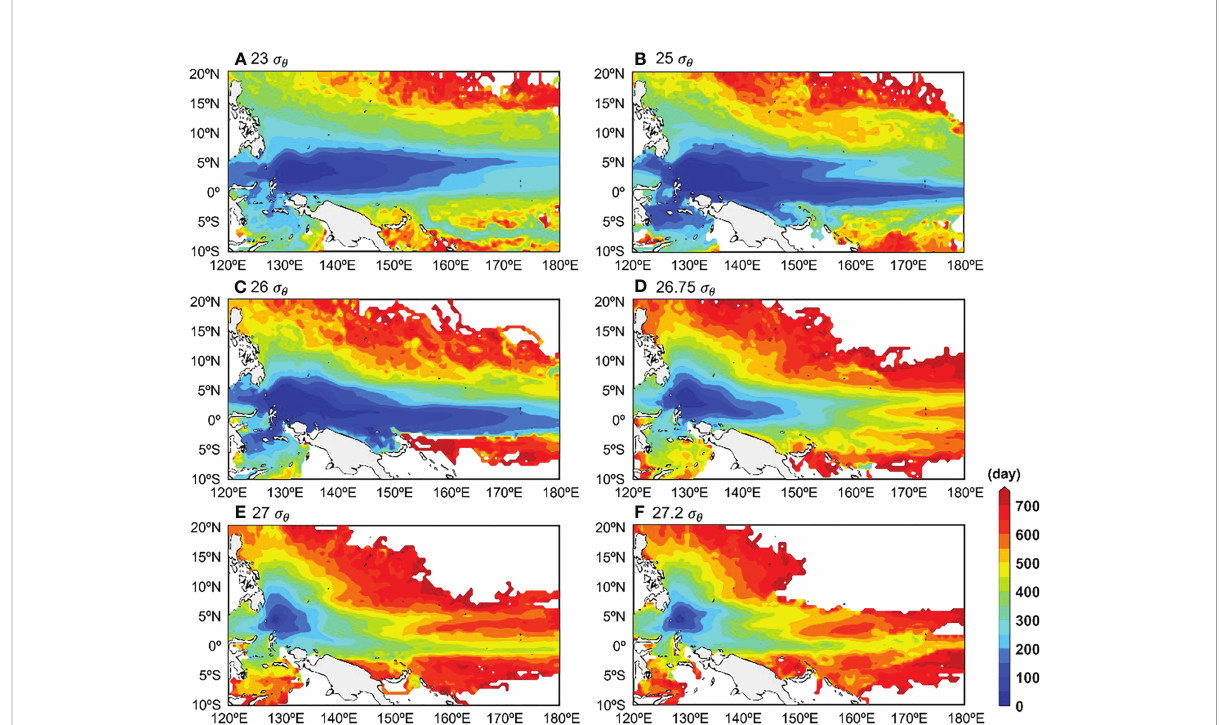
FIGURE 13 Mean travel time distribution of tracers (day) released at the WBE region at the isopycnal layers of (A) 23, (B) 25, (C) 26, (D) 26.75, (E) 27, and (F) 27.2 s q . The tracers (50 tracers/layer) were released every day from 1994 to 2013 with the travel time of two